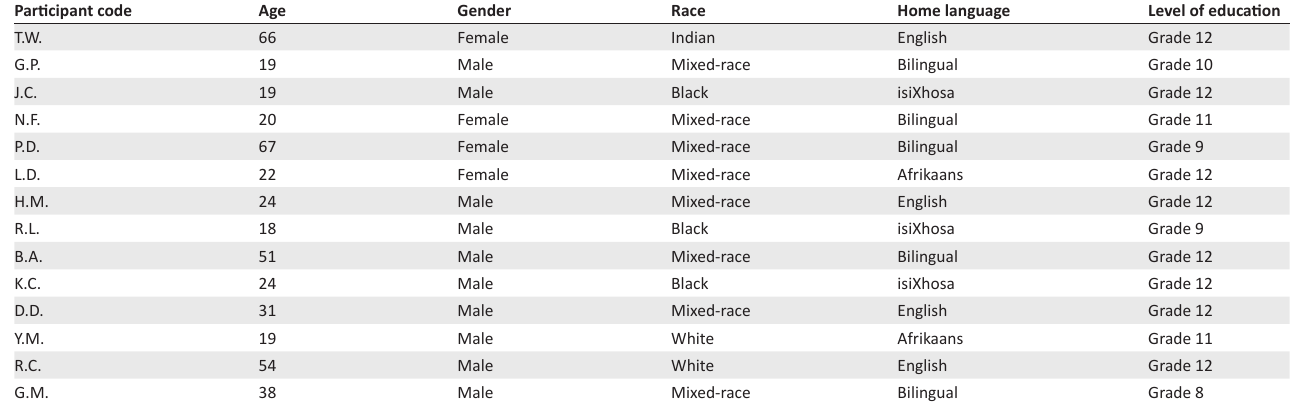
TABLE 1: Participants’ demographic